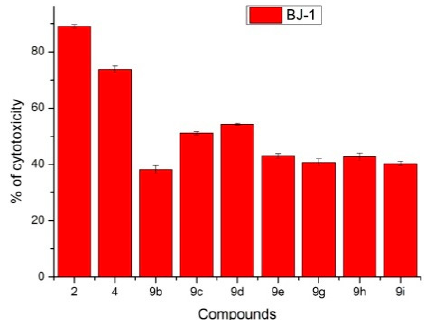
Figure 2. Screening the cytotoxic activities of active compounds, in vitro, against skin human normal cell line (BJ-1). Preliminary concentration for screening was 100 ppm. Each result is a mean of 3 replicate samples. Table 1. BAX protein level (Pg/mL) of MCF-7treated with IC 50 of compound 9b (19.8 µg/mL) and IC 50 of 9g (26.2 µg/mL) compared to untreated cells and cells treated with reference drug Doxorubicin. BAX CONC.